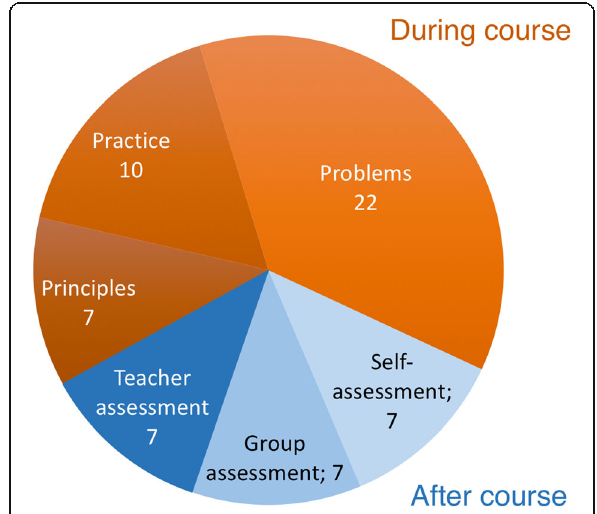
Fig. 3 The composition of points in the grading. Points from practice, principles, and problems accumulate during the course, and points from self-, group, and teacher assessments are given at the end of the course. The maximum number of points is 60, and passing requires half of these points. The exact composition of points can be adjusted, but this is our fair estimate for a balanced compromise, where passing the course is straightforward by abiding and persistent studying and difficult by random or cherry-pick studying. Near-fail students can, if necessary, be allowed to pass the course by compensating work (Arnold